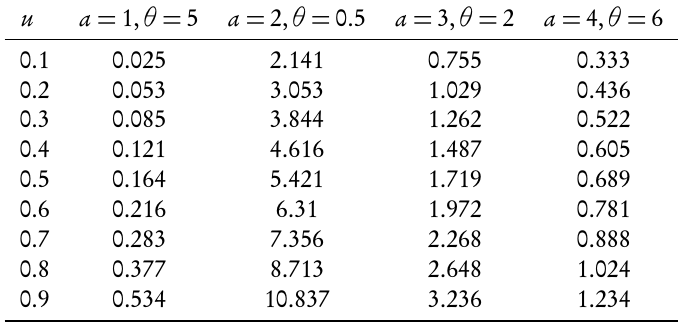
Table 2 represents the quantiles of ZBL distribution for selected values of the parameters a and θ . The values of quantiles of ZBL distribution for selected values of the